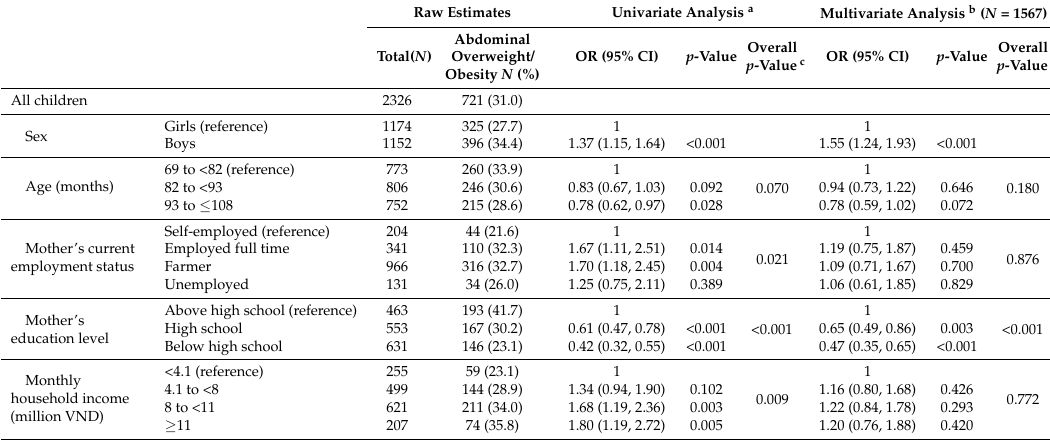
Table 8. Prevalence of abdominal overweight/obesity (WHtR ≥ 0.46 for boys and ≥ 0.45 for girls) and associated sociodemographic factors in 6–9-year-old children in rural areas of